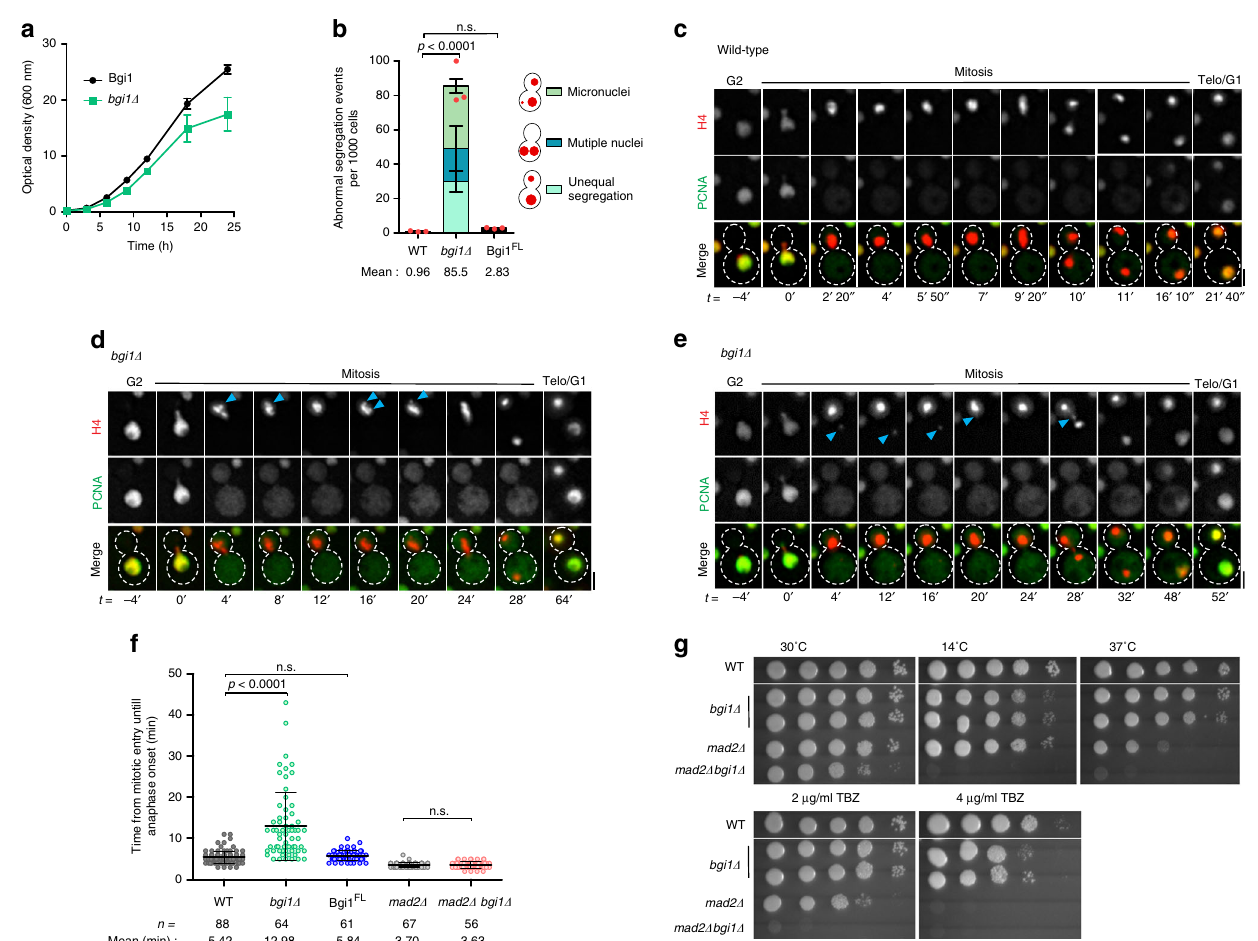
Fig. 4 Loss of bridgin function results in an increased rate of chromosome missegregation and impaired mitotic progression. a Growth curve of wild- type H99 and bridgin-null mutant strain SHR867 ( bgi1 Δ ::NEO ) at 30 °C. N = 3. b The rate of abnormal nuclear segregation events was measured at 30